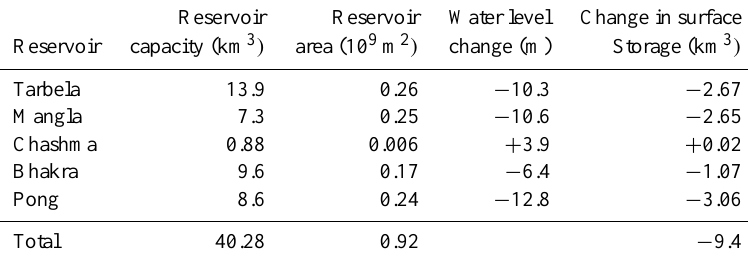
Table 1. Change in surface storage in the major reservoirs of Indus during 2007.